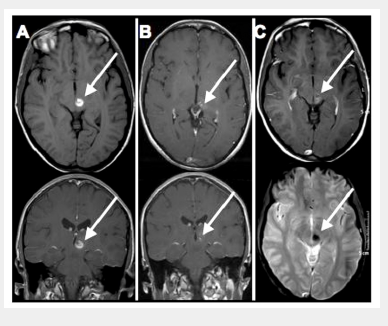
Left MRI images (A) show a typical mesencephalic cavernoma haemorrhage on the left side (arrows) in an axial T1 (no gadolinium-DTPA) and coronal T1 (with gadolinium- DTPA). The patient suffered from a slight headache and partial hemi-hypoaesthesia. Surgery in this case was not advised. The MRI images 2 months later (B) showed resorption of the acute haemorrhage with no sign of residual cavernoma (arrows). The MRI images after one year (C) confirmed the positive follow-up with complete resolution of all symptoms. The upper axial T1 (with gadolinium-DTPA) demonstrates again the old lesion with no sign of recurrence. The lower axial MRI image is a special sequence (gradient echo) to detect haemosiderin in the brain. It shows the old lesion and status after haemorrhage, which should not be mistaken for a new